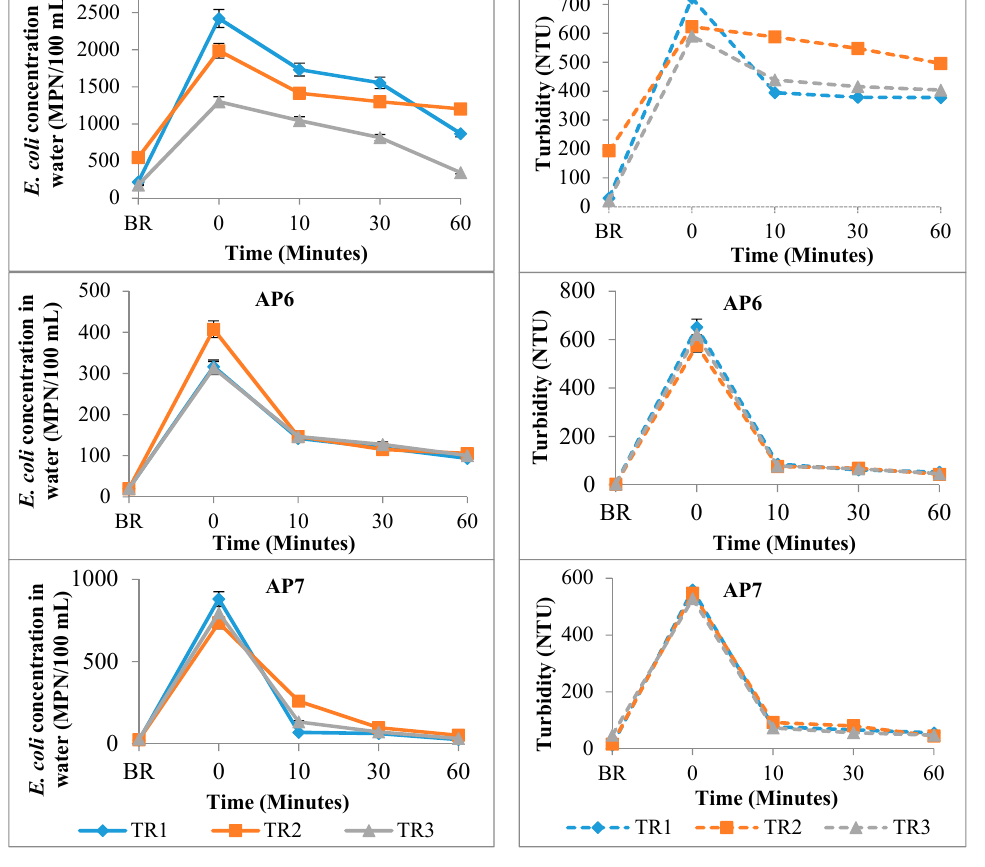
Figure 3. Escherichia coli (solid lines) and turbidity (dashed lines) results in the water column for the mechanical sediment disturbance experiment in the laboratory for the three experimental rounds (TR1–TR3); BR: before resuspension.